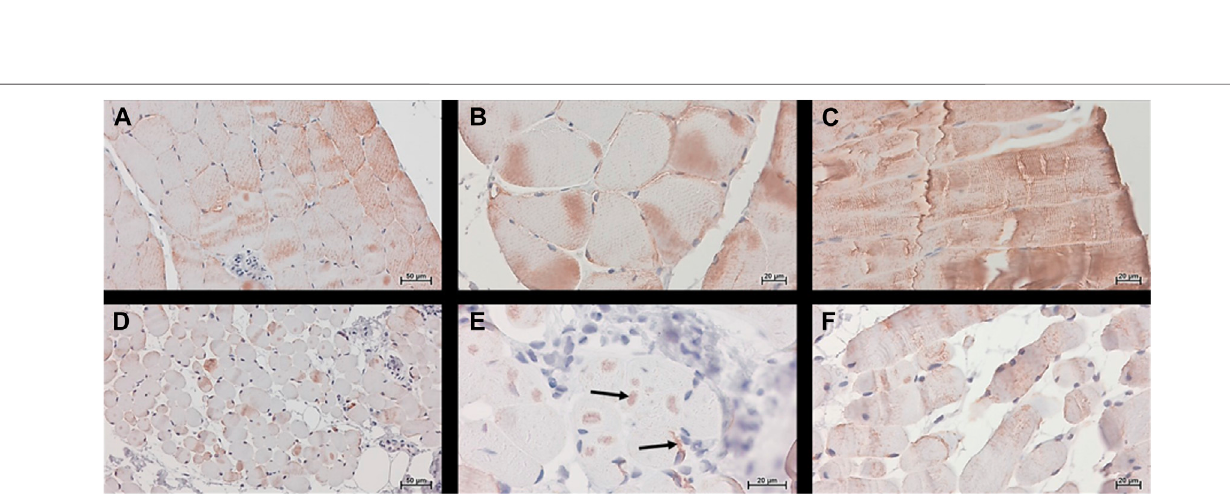
( Figure 11 ). All trends of the mutant protein showed different